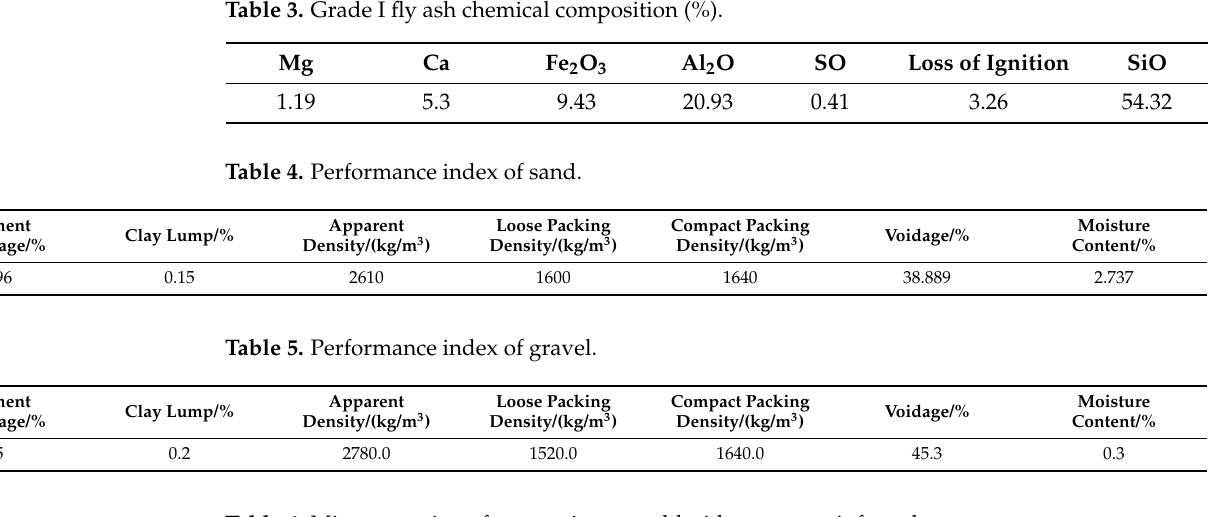
Table 2. Magnesium chloride chemical composition.